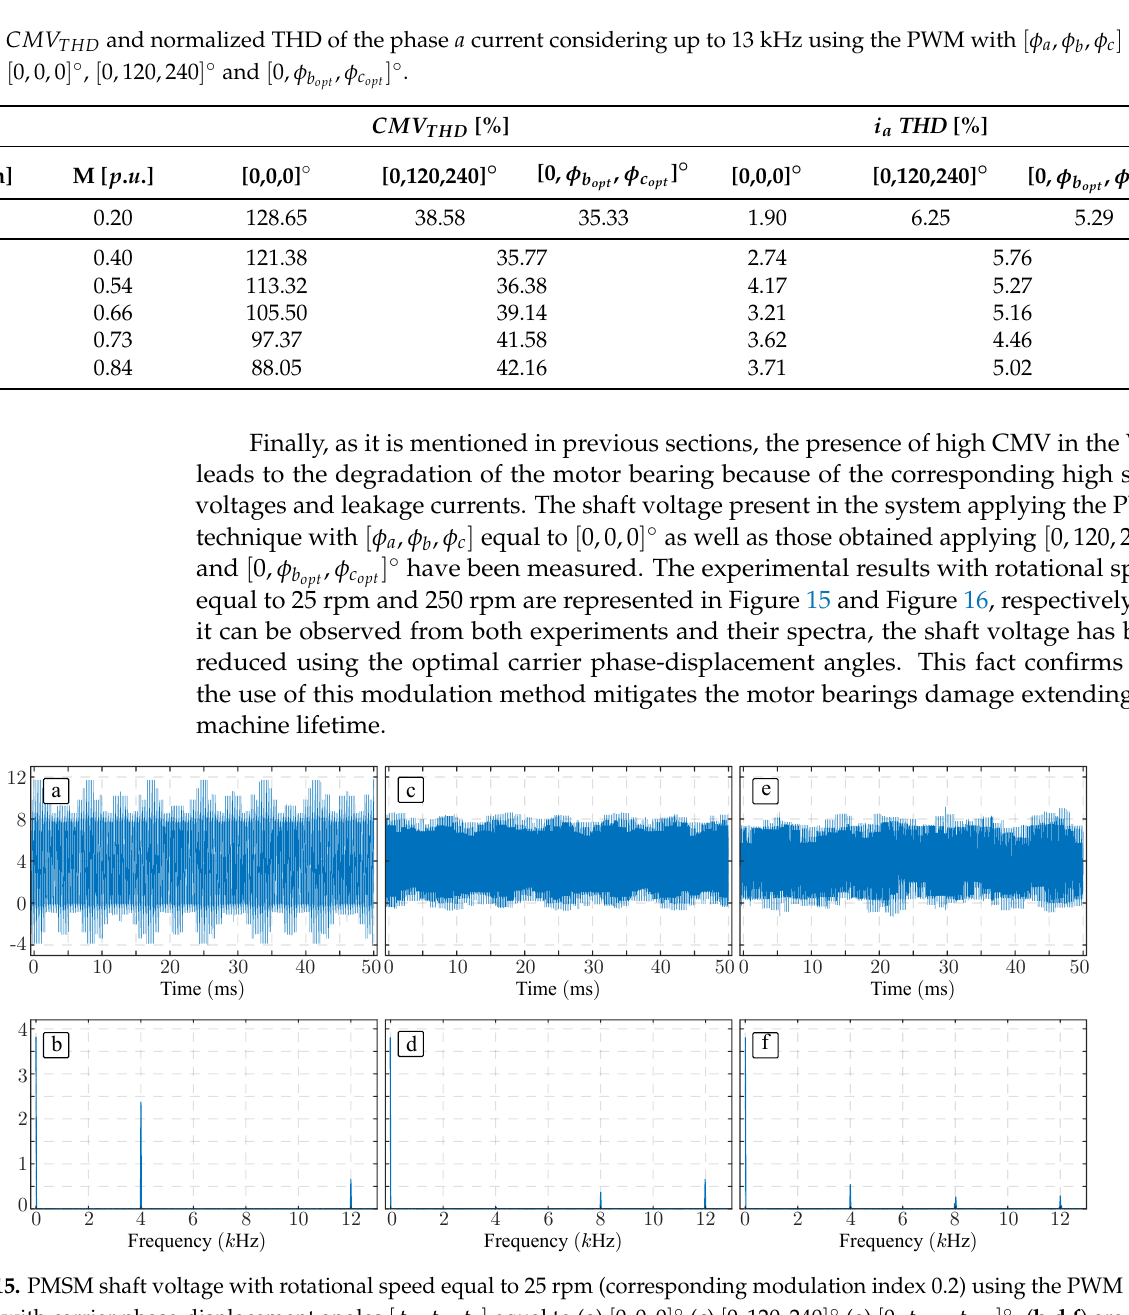
Table 2. CMV THD and normalized THD of the phase a current considering up to 13 kHz using the PWM with [ φ a , φ b , φ c ] equal to [ 0,0,0 ] ◦ , [ 0,120,240 ] ◦ and [ 0, φ b